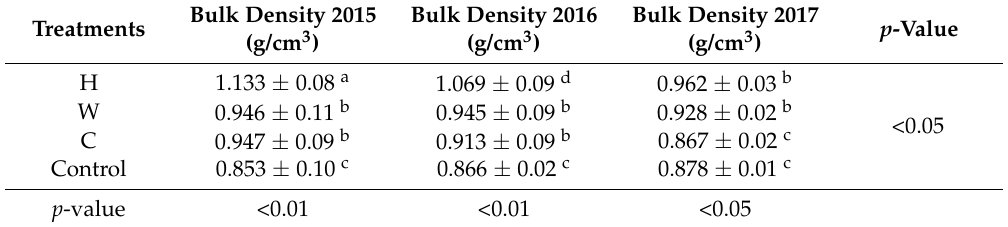
Table 7. Results of the ANOVA and Tukey test for soil bulk density (BD) during the three years after felling (df 3, 144; average ± SD), difference tested between the soil of the harvested area, and control. Bulk Density 2015 Bulk Density 2016 Bulk Density 2017 Treatments (g/cm 3 ) (g/cm 3 )